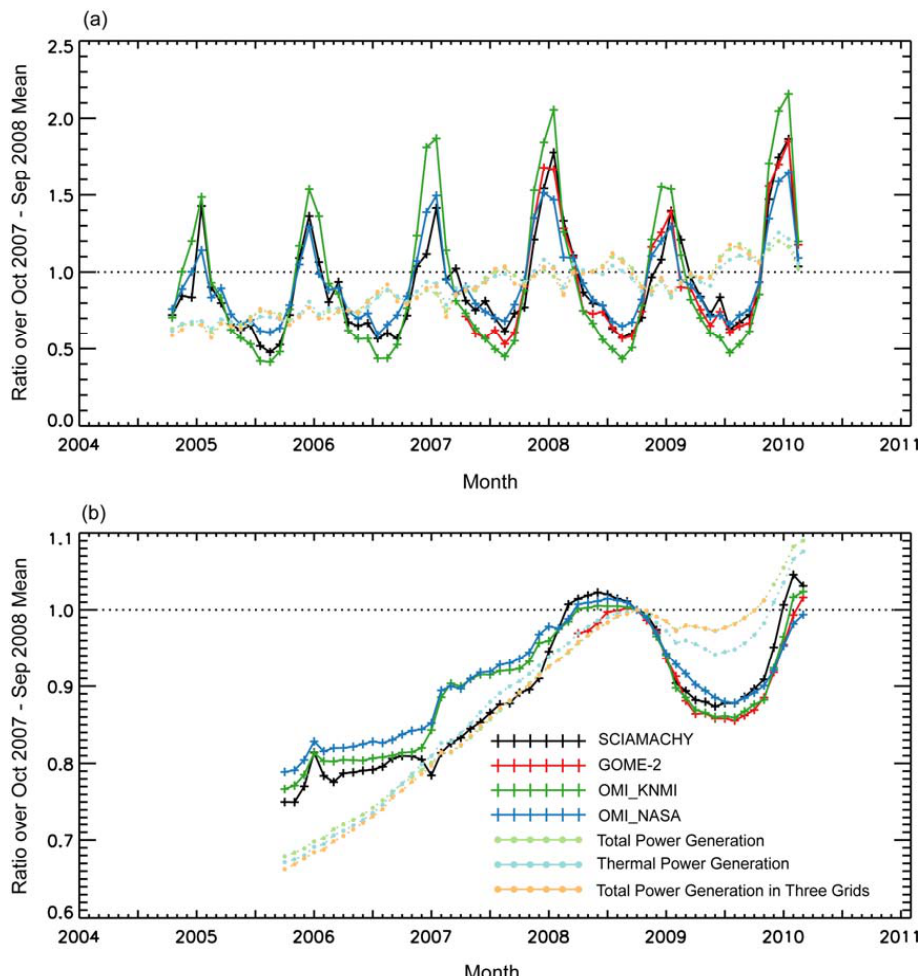
Fig. 3. (a) Monthly variations in regional mean VCDs of NO 2 and power generation in China relative to values averaged over the 12-month period of October 2007–September 2008. (b) Corresponding variations after a 12-month moving average: each point represents the mean over prior 12 months; and an increase (decrease) of value denotes a year-on-year increase (decrease) in VCDs of NO 2 or power